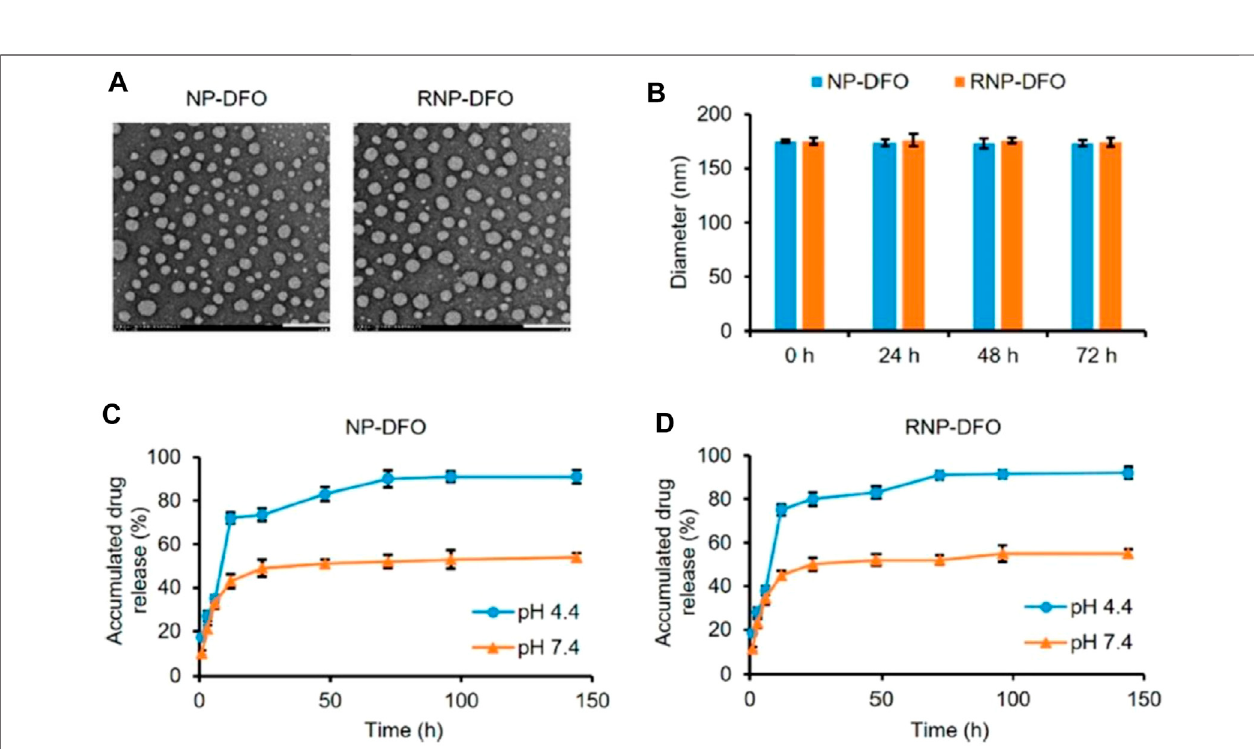
FIGURE 7 | Characterization of DFO-loaded nanoparticles. (A) Photomicrographs of NP-DFO and RNP-DFO taken through TEM depict their smooth spherical morphology. Scale bar = 200 nm. (B) Diameter of NP-DFO and RNP-DFO before (0 h) and after being incubated in PBS (pH 7.4) for different periods as determined by DLS. No signi fi cant size change occurred in 72 h, suggesting that the nanoparticles are stable. Data are presented as mean ± SD from three independent experiments. (C,D) ReleasekineticsofDFOundermimicphysiologicalconditionsfromNP-DFO (C) andRNP-DFO (D) atpH4.4and7.4,respectively.Reprintedwithpermission from You et al., 2018 ( ACS Nano ). DFO, deferoxamine; NP, nanoparticle; TEM, transmission electron microscopy; PBS, phosphate-buffered saline; DLS, dynamic light scattering.